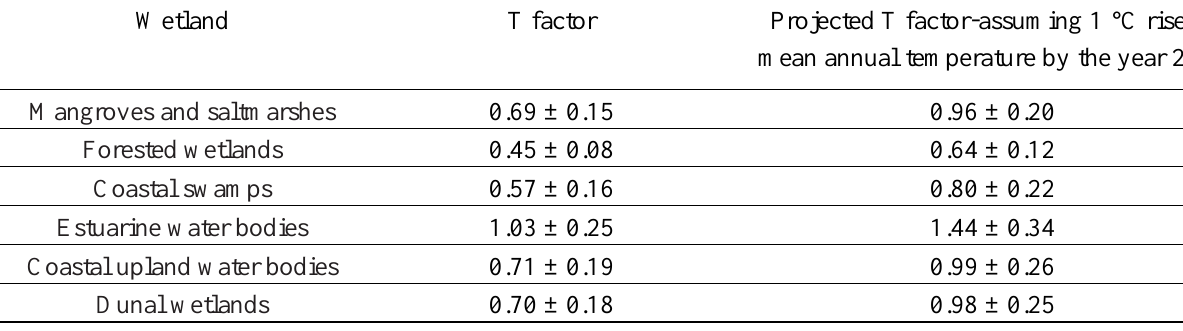
Table 4. T factor and standard errors for the wetland classes.